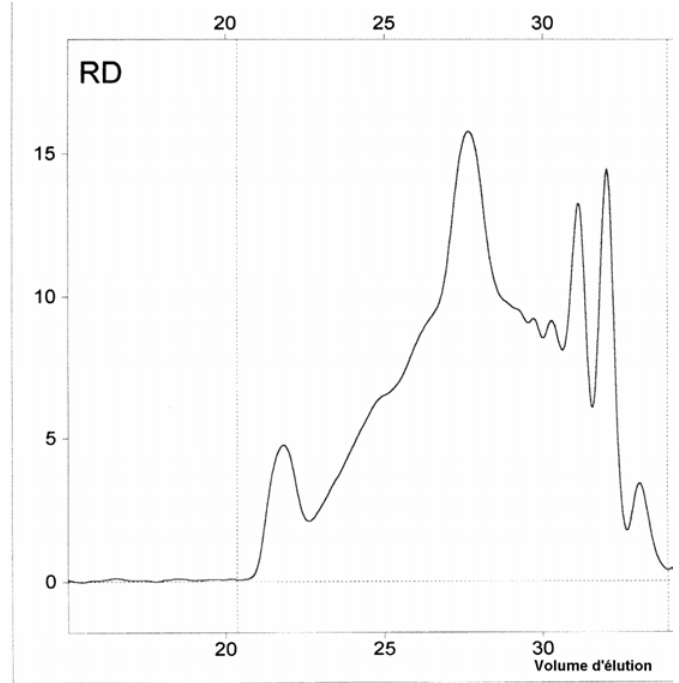
Figure 9. GPC curve of poly(ECH) prepared at 50 °C (5 % Maghnite0.25M, T = 2h 30